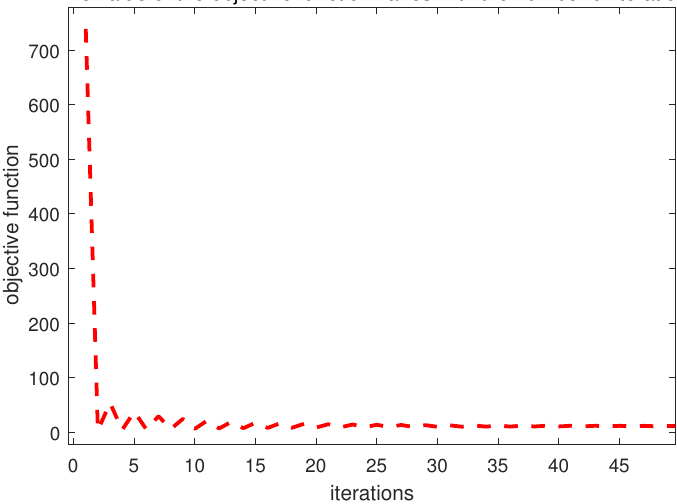
Figure 3. Convergence curve of the proposed UFS-ID approach.